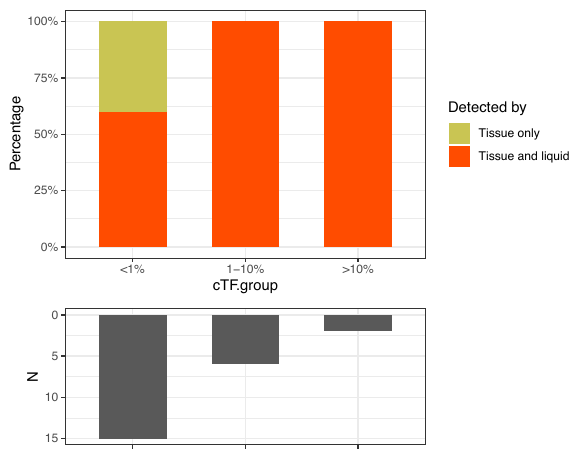
Fig. 4 Amount of tumor shed is directly correlated with the ability of a liquid biopsy to detect RET fusions. The concordance of tissue and liquid testing strati fi ed by composite tumor fraction (cTF) is as follows: 100% among 2 patients with greater than 10% cTF, 100% among 8 patients greater than 1% cTF and 40% (6) among 15 patients with less than 1%